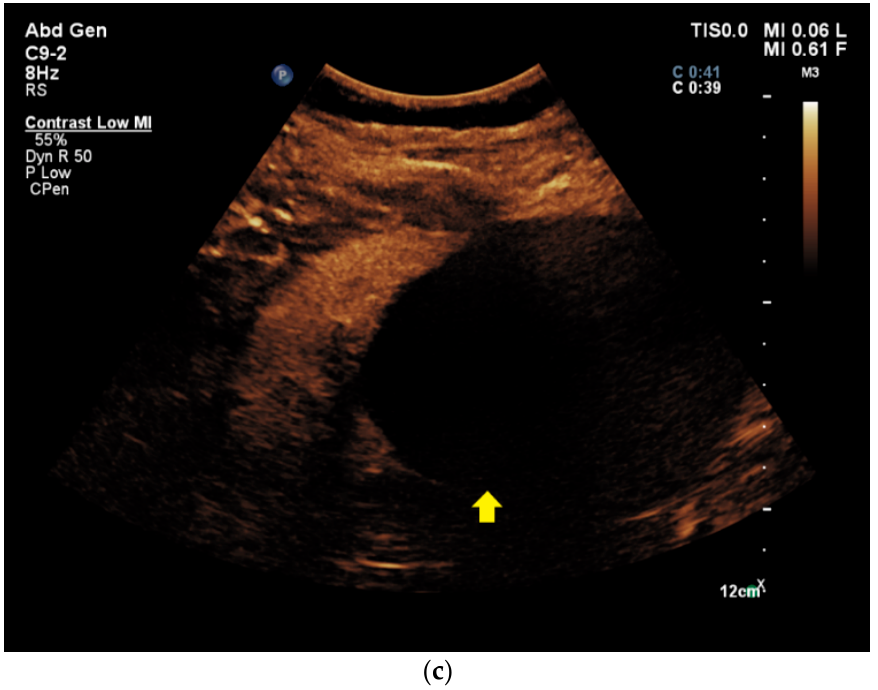
Figure 2. Contrast-enhanced ultrasound of a Bosniak II renal cyst. ( a ) In the native B-mode, a hypoechoic, homogeneous lesion with thin peripheral septa (yellow arrow) is detected in the right kidney. ( b ) The lesion shows no hypervascularization in Color Doppler (yellow arrow). ( c ) After the intravenous application of SonoVue ® , no contrast-enhancement of the lesion can be visualized (yellow arrow).